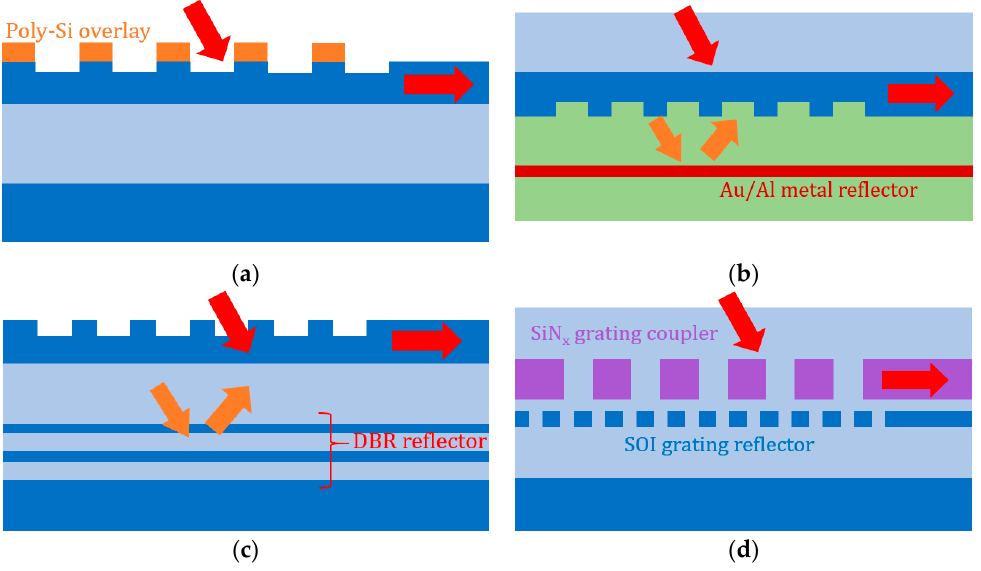
Figure 5. Additional fabrication techniques to enhance GC directionality: ( a ) GC with poly ‐ silicon overlay; ( b ) GC with metal reflector, fabricated by flip ‐ chip and benzo - cyclobutene ‐ bond; ( c ) GC with distributed Bragg reflector; and ( d ) GC with silicon grating reflector on silicon ‐ nitride ‐ on ‐ silicon platform.